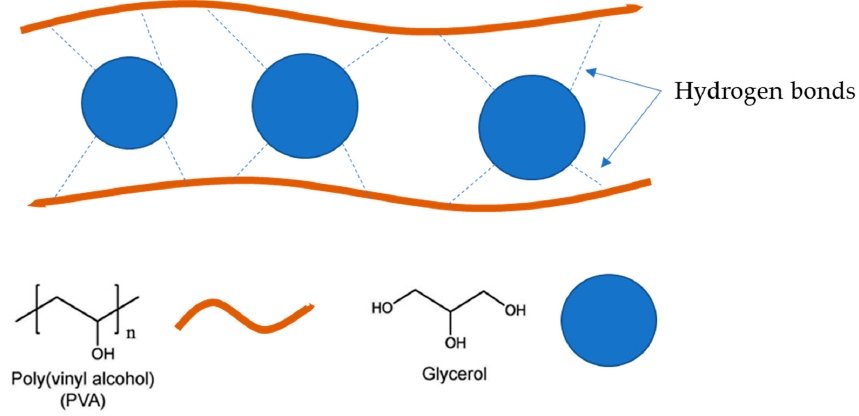
due to the higher glycerol content present in these nanofibers. Figure 7. Schematic illustration of the H-bonding between glycerol and PVA.